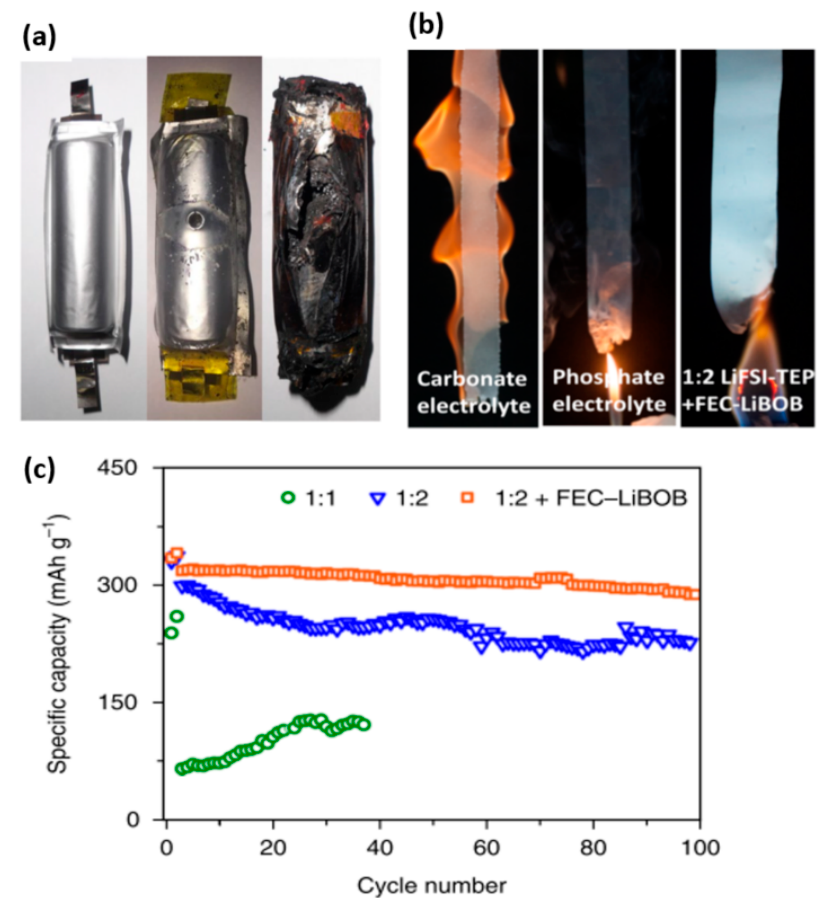
Figure 5. ( a ) Blank cell before nail penetration test for 18,650 cells using 1:2 LiFSI–TEP (Triethyl phosphate) + FEC–LiBOB electrolyte (middle) and commercial carbonate electrolyte (1.0 M LiPF 6 /EC:DEC:EMC, v / v / v = 1/1/1). ( b ) Flame tests of 1.0 M LiPF 6 /EC:DEC:EMC ( v / v / v = 1/1/1) electrolyte, 1:2 LiFSI–TEP electrolyte, and 1:2 LiFSI–TEP + FEC-LiBOB electrolyte. ( c ) Cycling performance at current density of 20 mA · g − 1 with different electrolytes [27]. Reprinted with